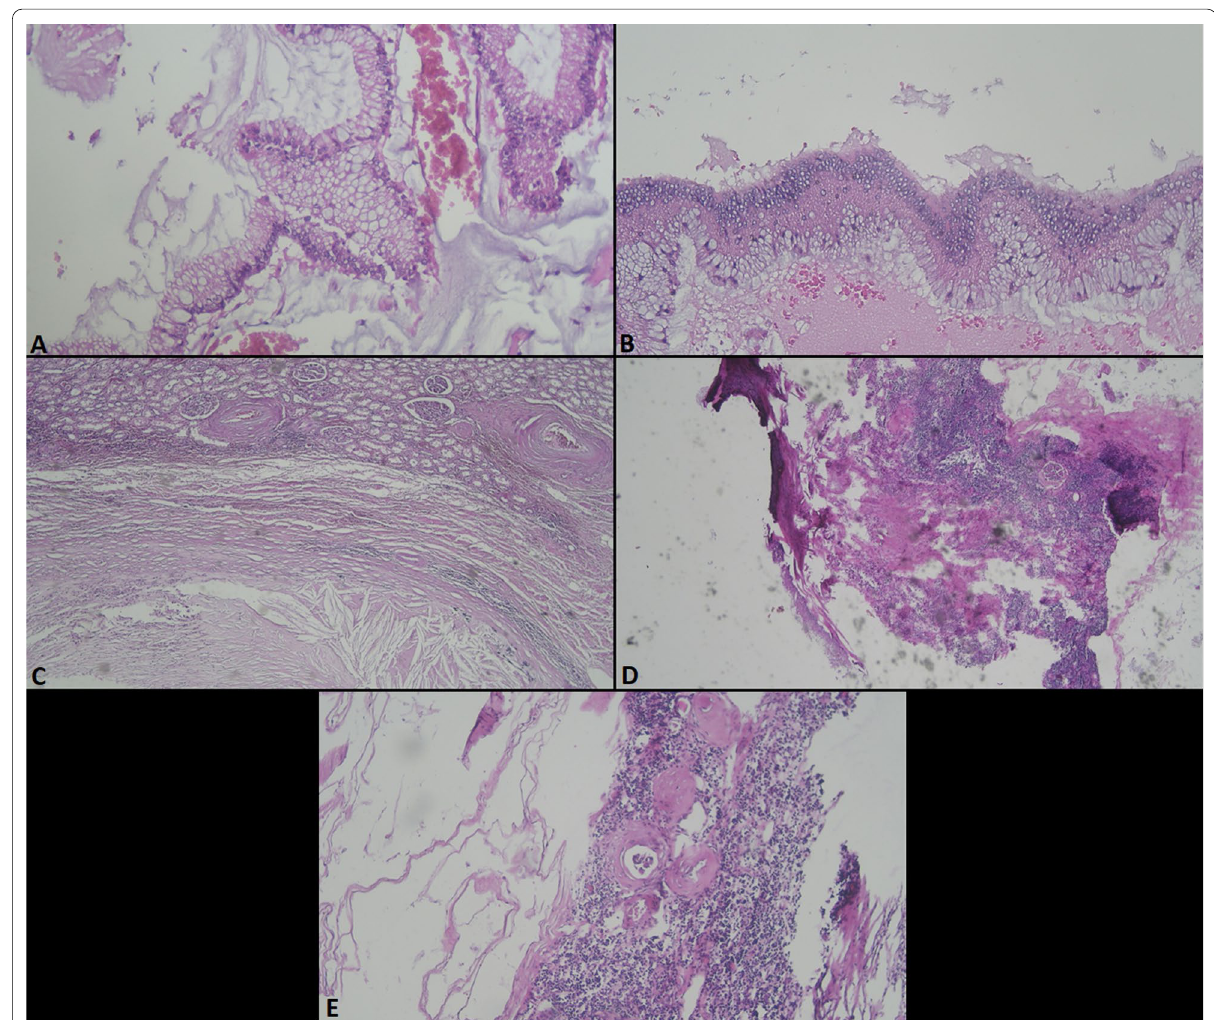
Fig. 2 Microscopic sections show renal cyst lined by a single layer of columnar mucinous epithelium ( A ), with focal pseudo-stratification ( B ). The cyst contains mucoid material and cholesterol clefts ( C ). Peri-cystic renal parenchyma reveals chronic leukocyte infiltration ( D & E